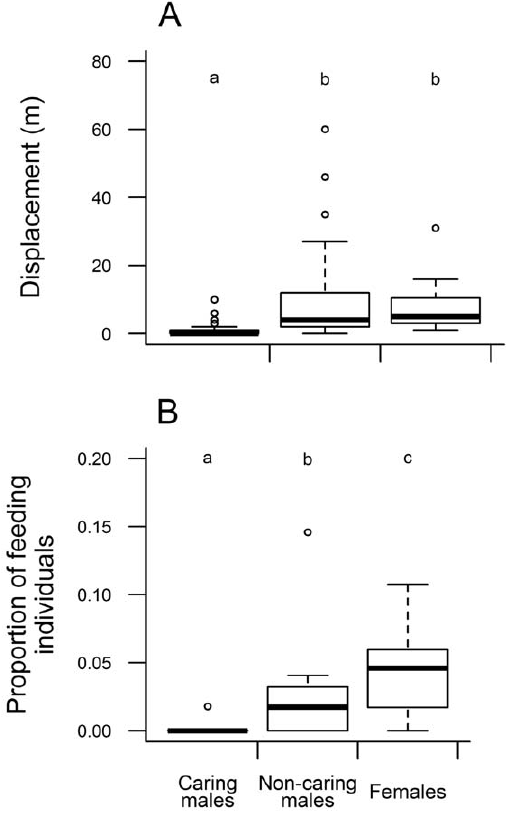
Figure 3. Movement pattern and feeding activity of Iporangaia adults. (A) Estimated distances that individuals in different parental states moved in consecutive capture occasions. (B) Observed propor- tion of individuals (females, caring and non-caring males) found in feeding activities in the field. Different letters represent differences among